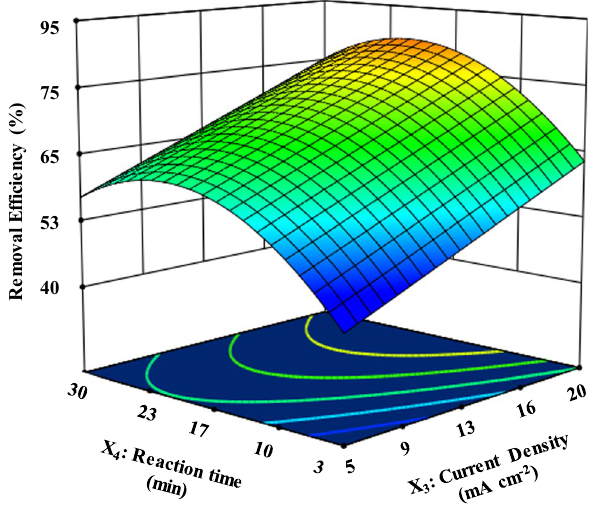
Fig. 5 The 3D plot of the reaction time and current density effects on the HDZ removal efficiency